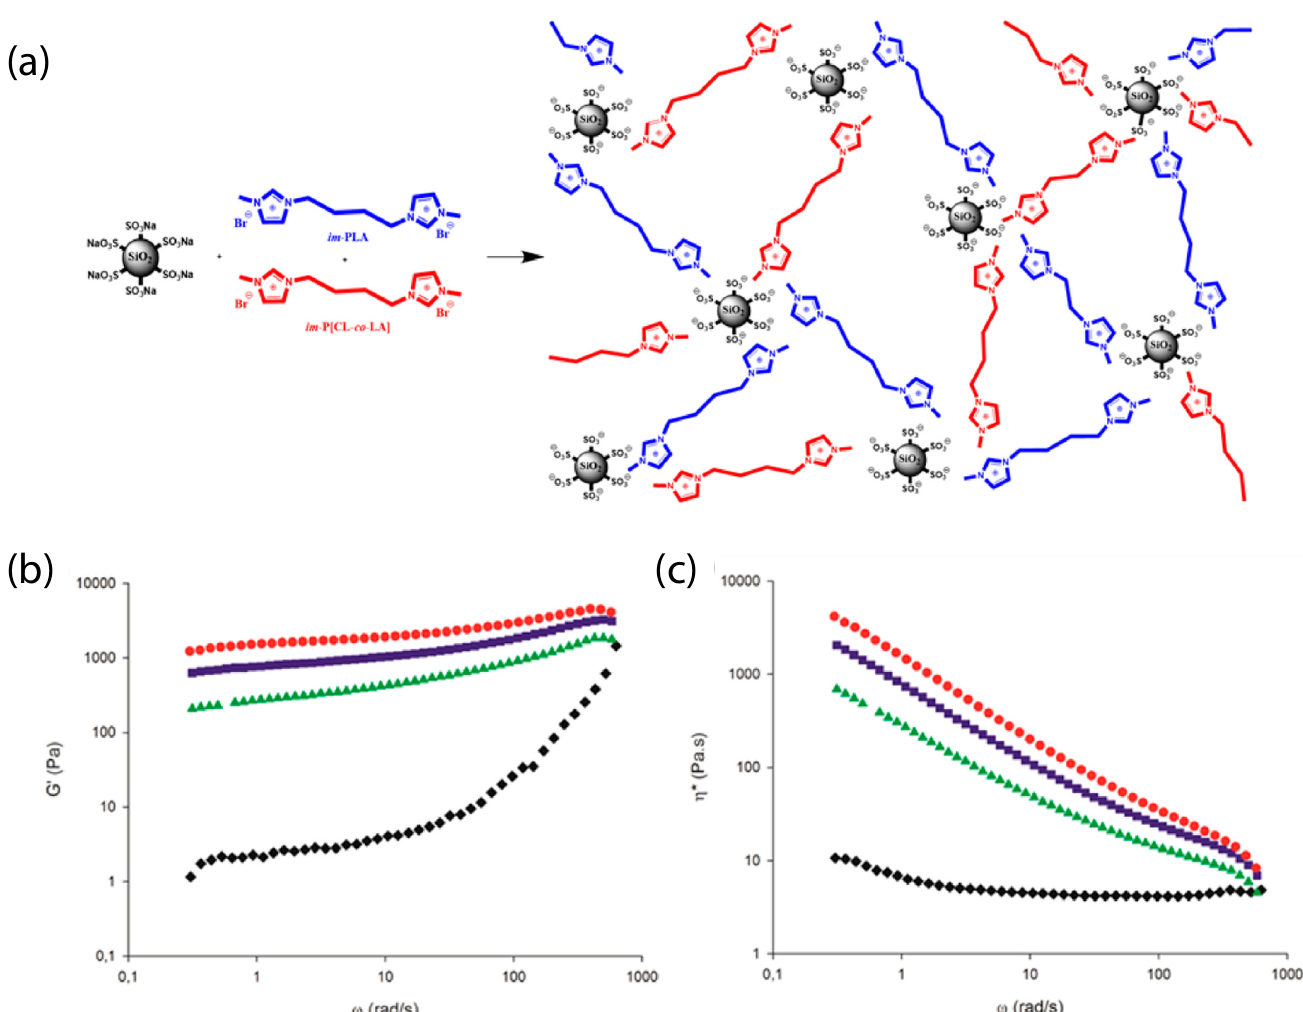
Figure 13. ( a ) Schematic of ionic organic hybrids based on PLA and imidazolium terminated PLA and P[CL-co-LA] oligomers and sulfonated nanosilicas. ( b ) Storage modulus G (cid:48) and ( c ) complex viscosity η ∗ as a function of the angular frequency at 180 °C PLA/im-PLA/im-P[CL-co-LA] (50/25/25 wt%) (black diamonds) and corresponding hybrids containing 1 wt% (green triangles), 3 wt% (blue squares), and 5 wt% (red circles) of sulfonated nanosilica. Reprinted with permission from Odent et al.